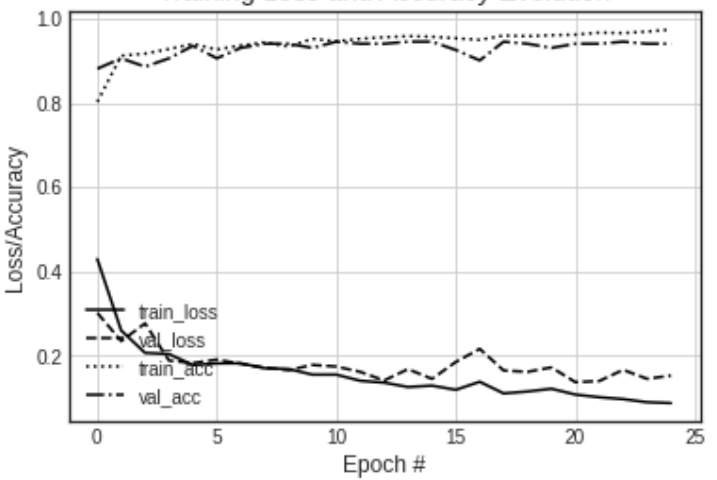
Figure 5. Evolution of the training of VGG16 CNN.